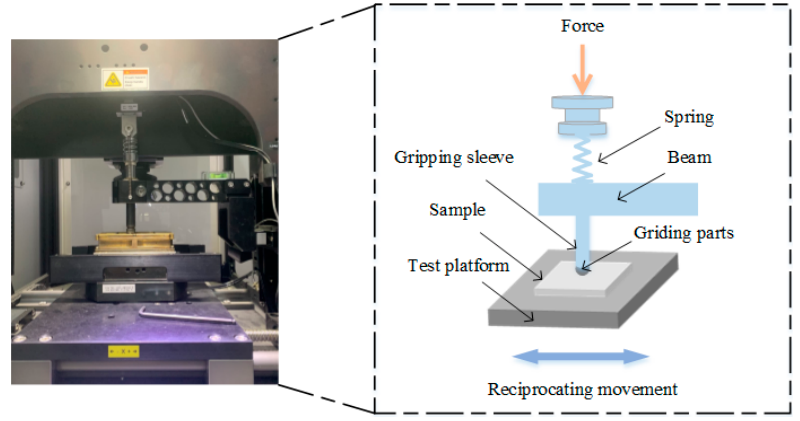
Figure 2. Schematic diagram of the friction and wear